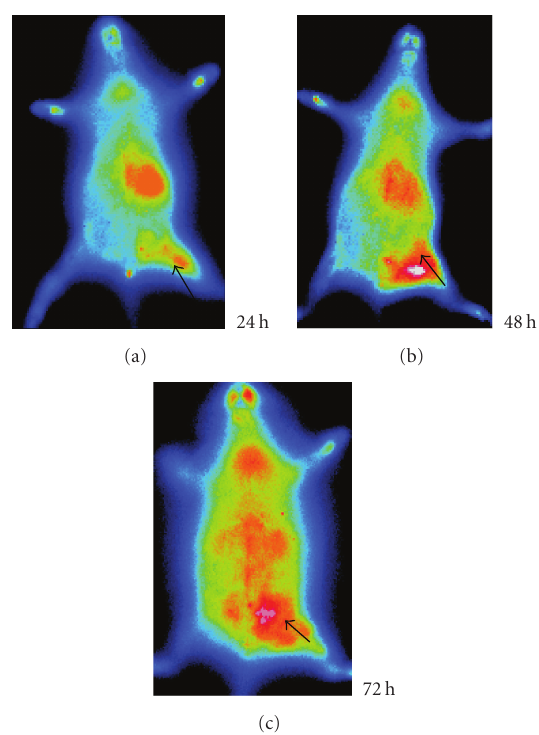
Figure 4: Serial images of S. aureus group at di ff erent times: the left thigh inflammation foci accumulated much more radioactivity of 125 I-anti-MIF McAb; the highest was at 48hours.